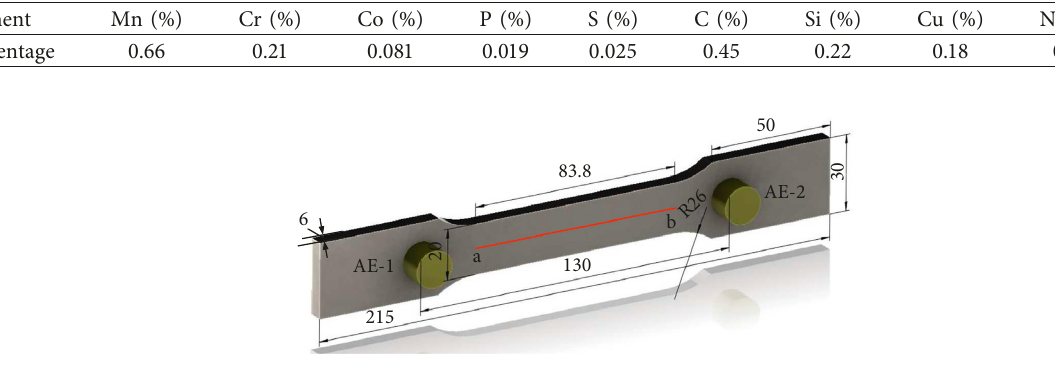
Table 1: Elemental mass fraction of 45 steel specimens.